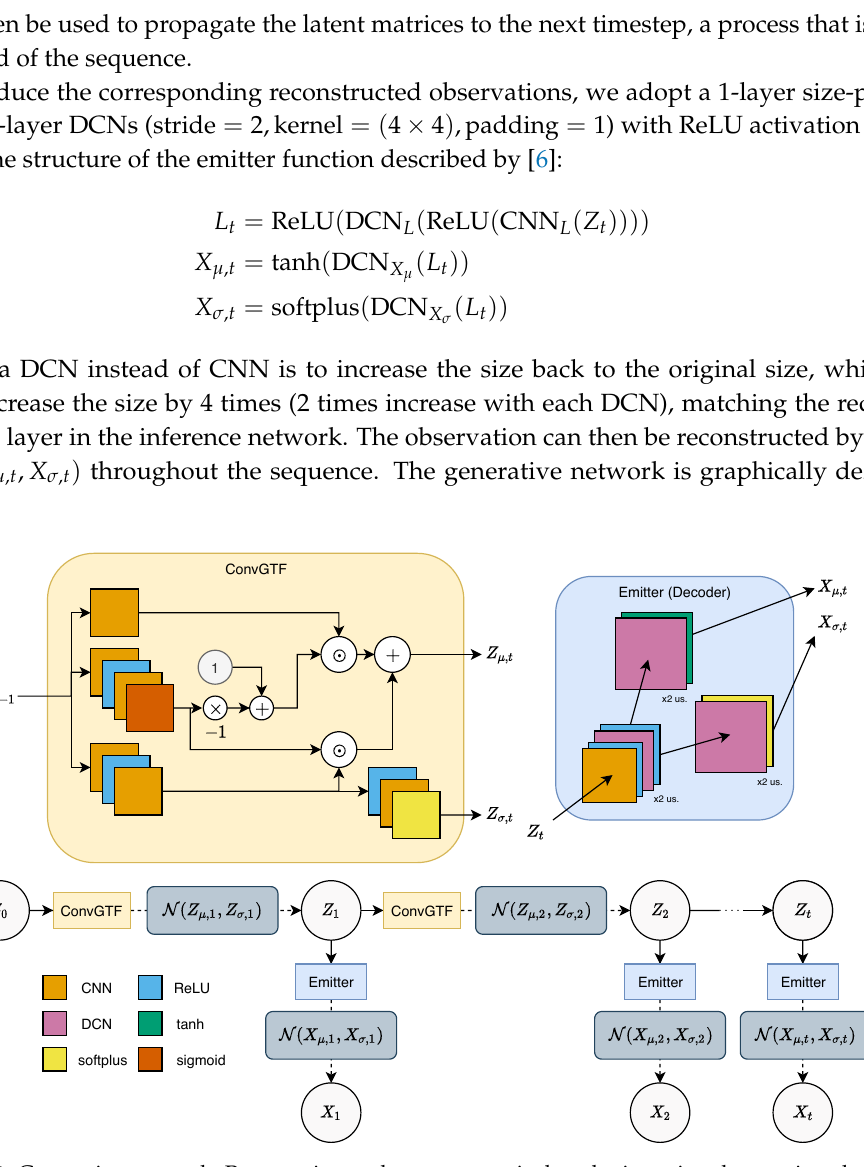
Figure 2. Generative network. Propagation on latent tensors is done by inserting the previous latent to a convolutional gated transition function (ConvGTF) to obtain latent mean and variance, which will then be used to sample the next latent. Observation is produced by inputting the latent into Emitter to output the observation mean and variance, which will be used to sample the observation. “x2 us.” denotes a two-times increase in spatial size (upsampling). Similar to Figure 1, dashed lines denote sampling, while dotted lines denote